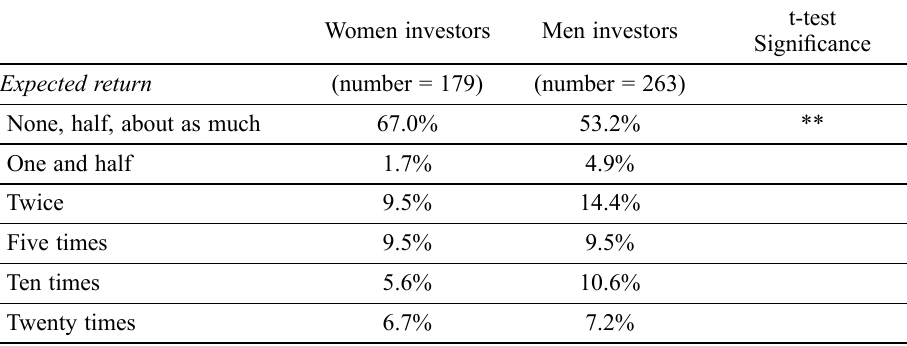
Table 8. Gender differences of Chilean informal investors on expected returns